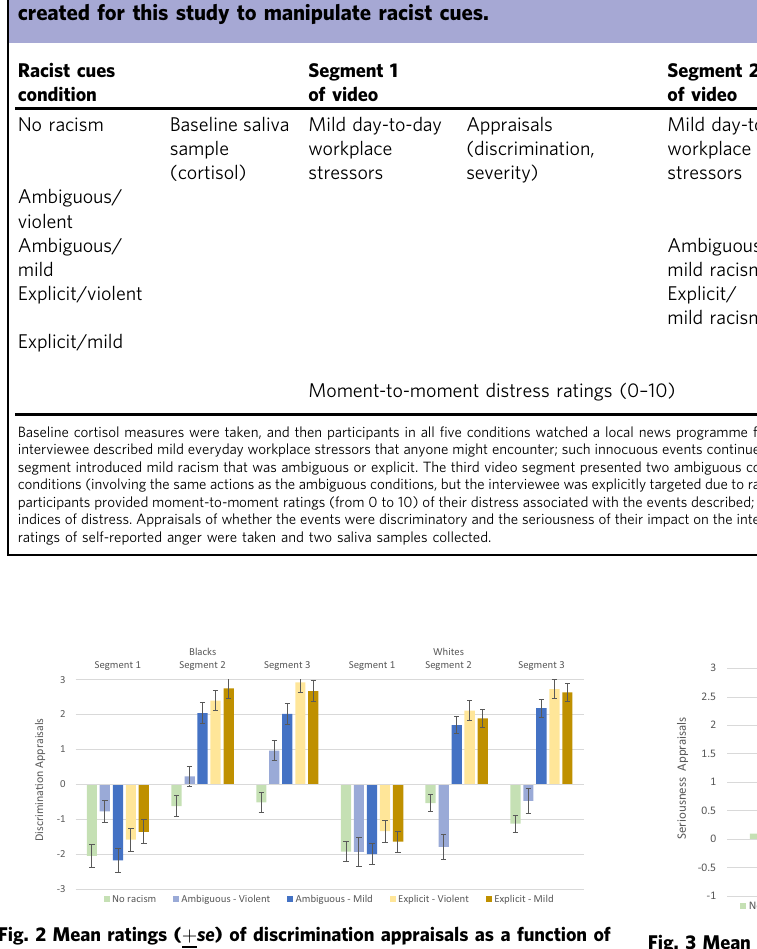
(8,398) = 2.59, p = 0.009, η 2 = 0.049. As expected, distress was